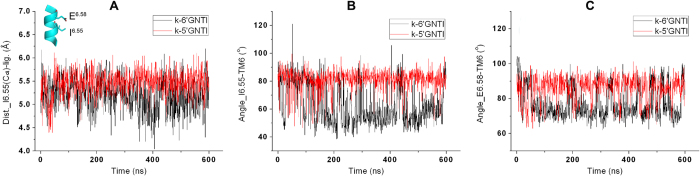
Comparisons of the contribution of I2946.55. (A) Evolution of the minimum distances between Cα of the residue I2946.55 and GNTIs. (B,C) Evolution of the angle between the residue I2946.55 and TM6 (B) or between the residue E2976.58 and TM6 (C).